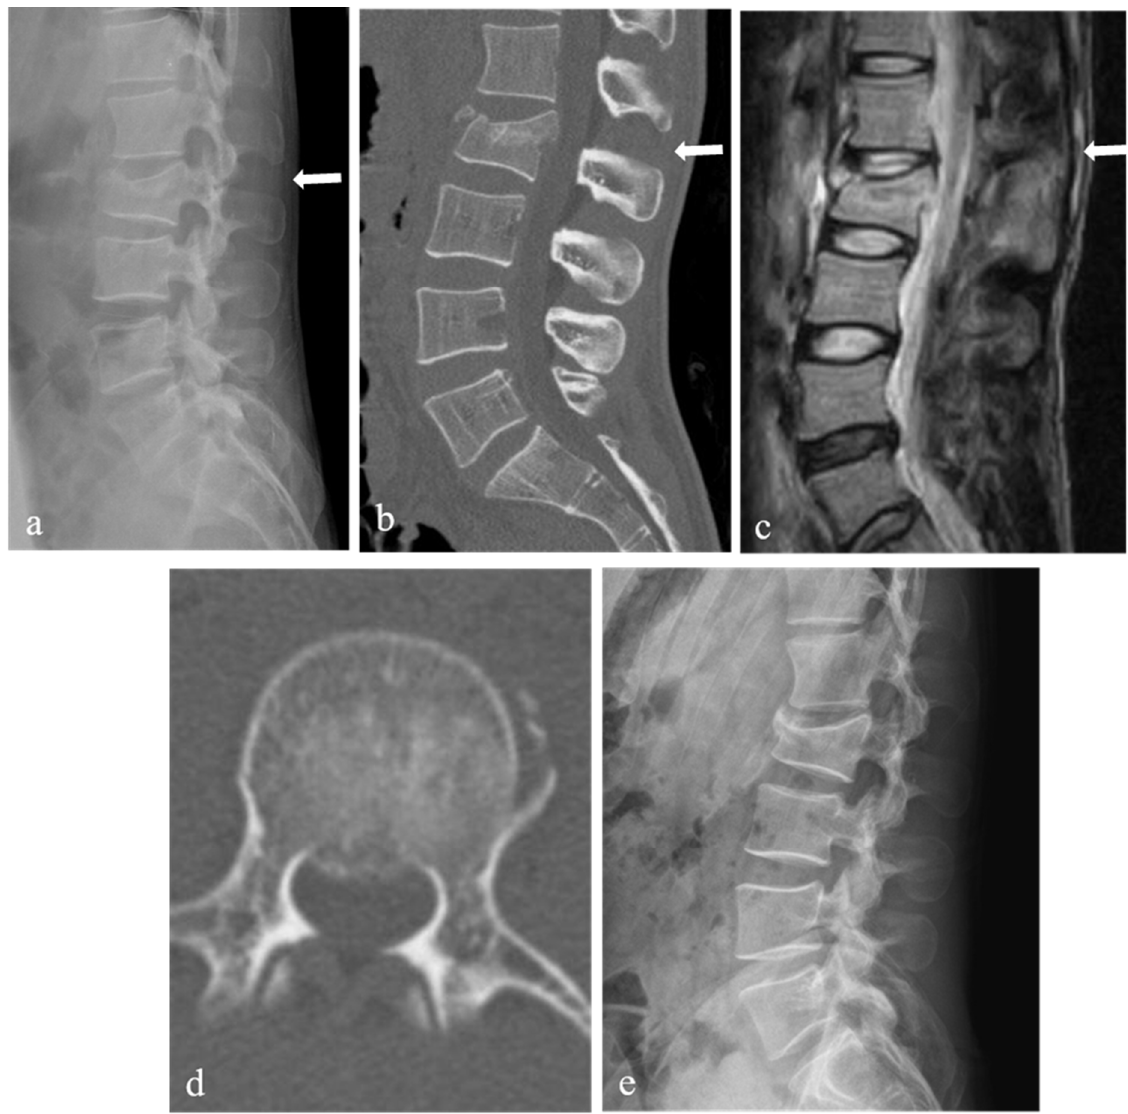
Figure 3. L2 burst fracture of a 39-year-old male patient with intact neurological status. Lateral X-ray ( a ) and sagittal 2-dimensional (2-D) computed tomography (CT) scan ( b ) showing L2 burst fracture with a widening of the L1-2 interspinous space (arrow), kyphotic angle of 11 degrees, and loss of vertebral body height of 31%. T2-weighted sagittal magnetic resonance imaging ( c ) showing signal change (arrow) without clear rupture of the posterior ligamentous complex. Axial CT scan ( d ) showing spinal canal compromise of 19%. At 28 months follow-up after injury, lateral X-ray ( e ) showing good spinal alignment and bony healing.